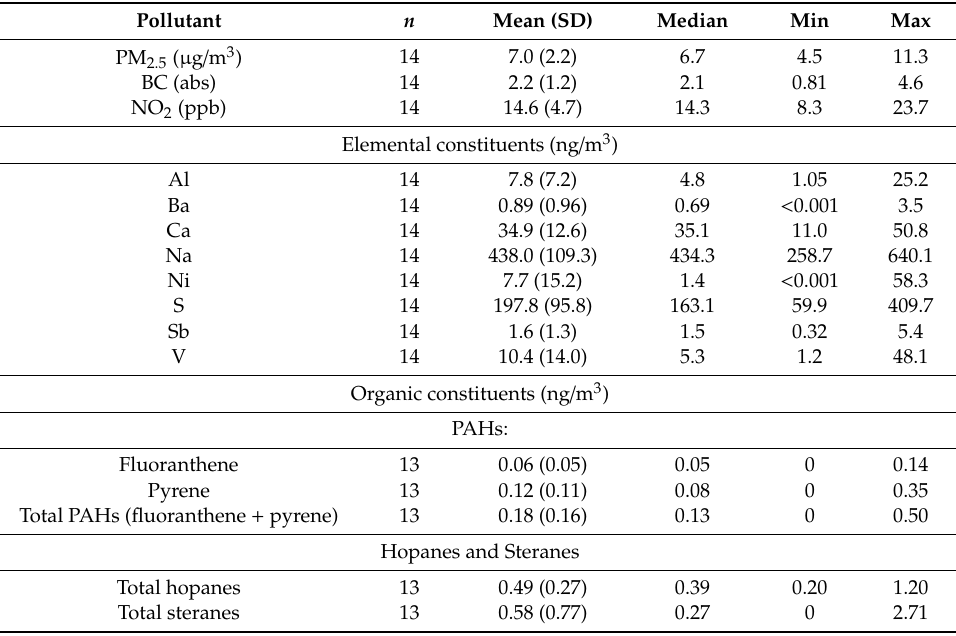
Table 1. Temporally-adjusted pollutant concentrations across sites. Organic constituents were not blank-corrected because no concentrations > LOD were detected at Albert Park reference site, and thus temporal adjustment could not be performed. The sample size ( n ) for organics is 13, as one sample was lost due to wet filters. PAH: polycyclic aromatic